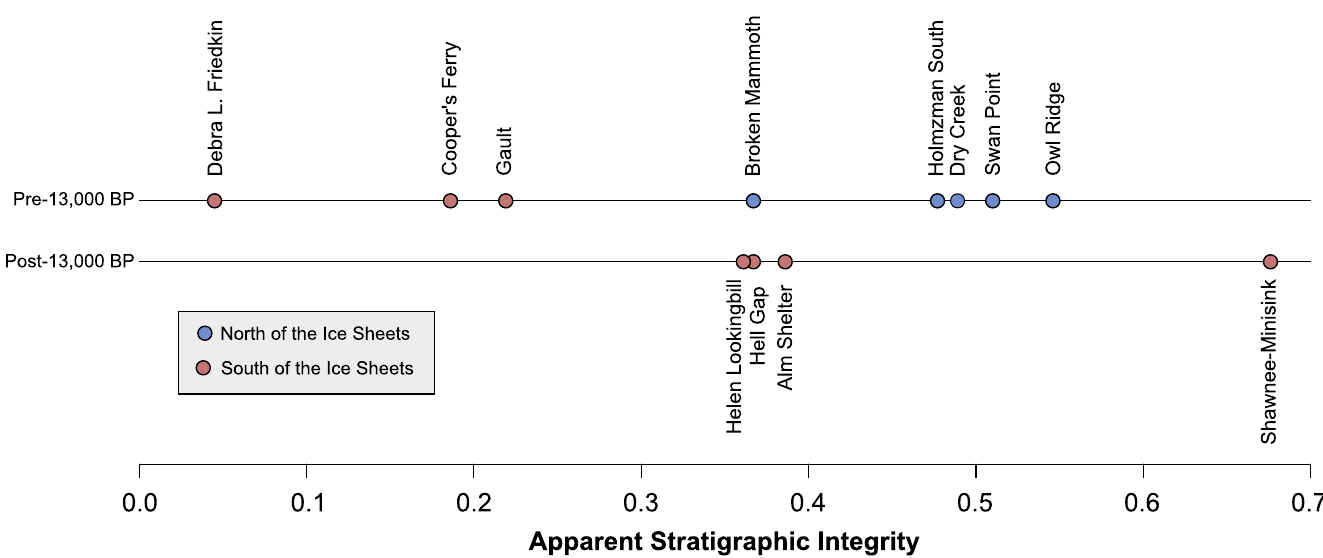
lowest ASI of any observed site at 0.045. The Gault site shows the highest apparent strati- graphic integrity of these three at 0.219. Cooper’s Ferry has an intermediate value, which could be inflated due to low artifact counts. Differences between the mean ASIs of early northern and southern sites are significant (Welch t-test, t = 5.359, df = 3.303, two-tailed p = 0.01). While the post-13,000 BP sites south of the ice sheets show extremely variable ASI from 0.343 (Helen Lookingbill) to 0.676 (Shawnee Minisink) (S5–S8 Figs), they are higher than all sup- posed pre-Clovis sites south of the ice sheets. They are also not of demonstrably different mag- nitude than the pre-13,000 BP sites north of the ice sheets (Welch t-test, t = 0.418, df = 3.87, two-tailed p = 0.698), but they are significantly greater than the southern pre-13,000 BP sites (Welch t-test, t = 3.096, df = 4.863, two-tailed p = 0.028).